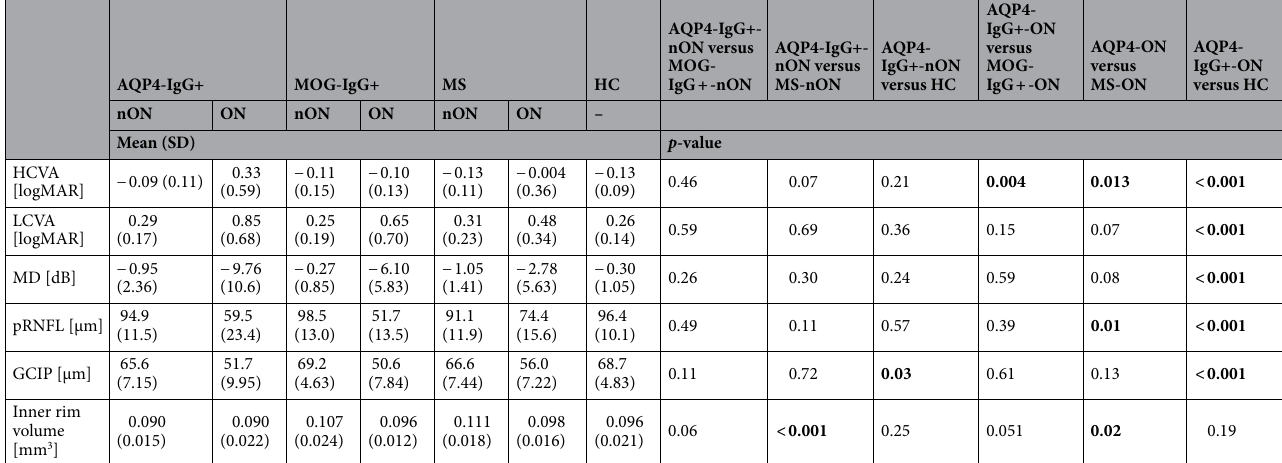
Table 2. Structural and visual function parameters. Test statistics from Mann–Whitney-U Test. AQP4- IgG +aquaporin-4-IgG seropositive patients, MOG-IgG +myelin-oligodendrocyte-glycoprotein seropositive